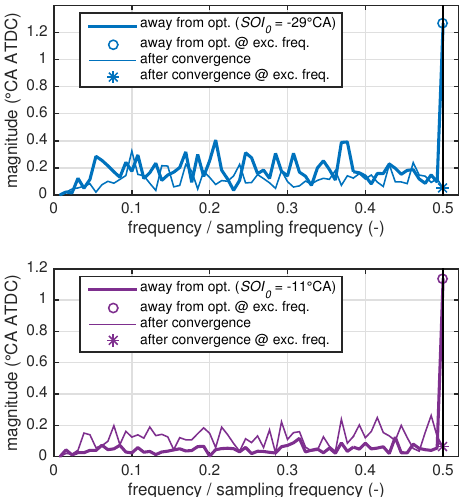
Figure 11. Magnitude plots of the discrete Fourier transforms (DFT) of the signals before and after